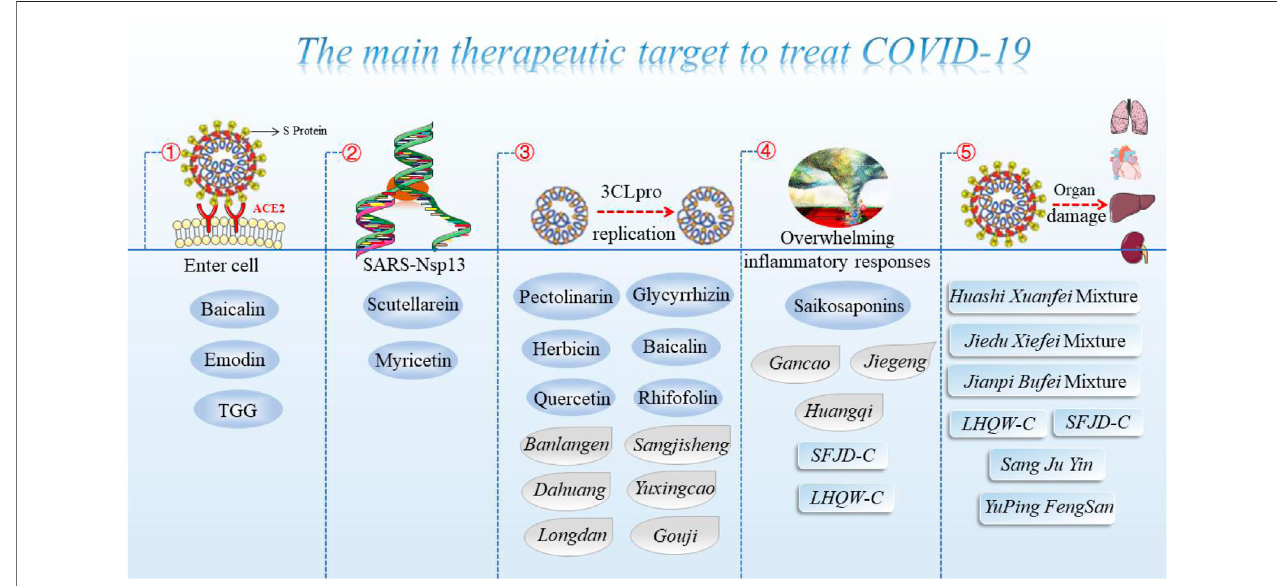
FIGURE 3 | The main therapeutic target to treat COVID-19 (target ACE2 strategy, SARS-Nsp13, 3CLpro, in fl ammatory responses, and organ damage).